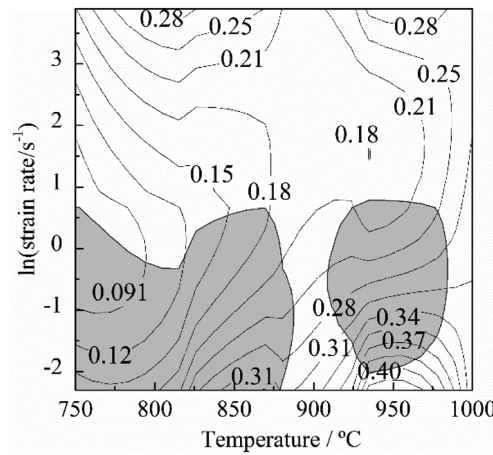
Figure 8: Processing map of 49MnVS3 non-quenched and tempered steel at strain of